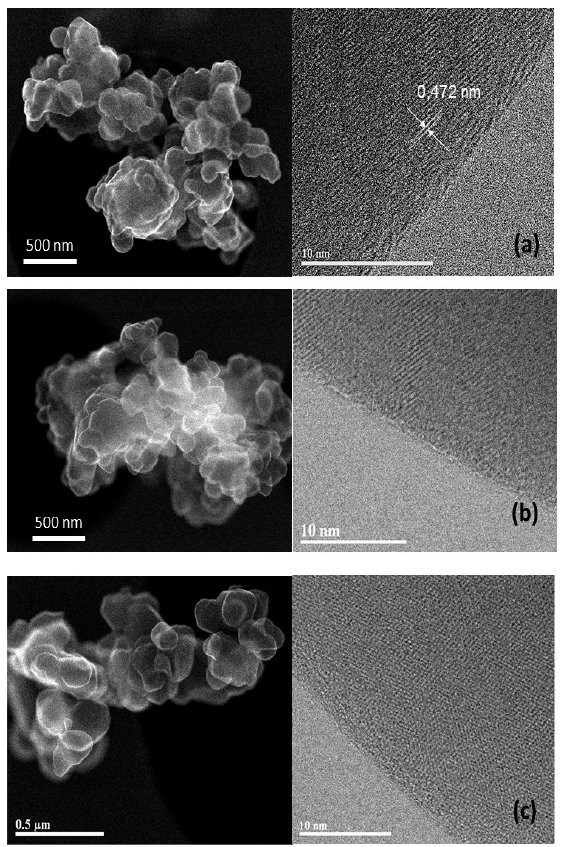
Figure 4. TEM images of ( a ) undoped, ( b ) Al ‐ doped, and ( c ) Mg ‐ doped NMC333 samples. The HRTEM micrographs reveal well ‐ defined lattice fringes with a separation of 4.72 Å corresponding to the (003) plane.